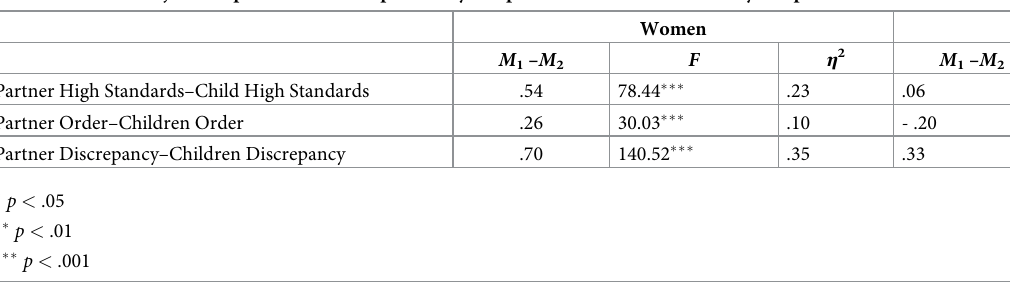
Table 4. Within-subject comparisons between partner dyadic perfectionism and children dyadic